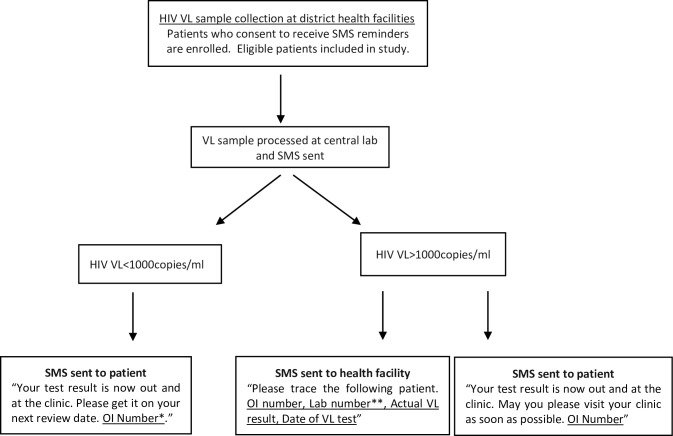
Summary of the mHealth programme.* OI number: unique patient ART identifier **Lab number: unique patient identifier in the laboratory.